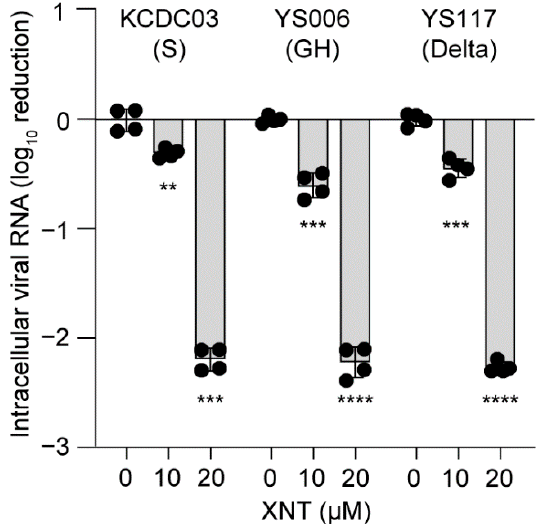
Figure 5. Inhibition of SCoV2 variants by XNT. Intracellular and extracellular viral RNA titers, de- termined 24 h after treatment of Vero E6 cells infected with SCoV2 KCDC03 (S clade), YS006 (GH clade), or a delta strain YS117 at an MOI of 0.01. Bar graphs show the mean with data points (two from each set) from two biological replicates. Vehicle, 0.1% DMSO. ** p < 0.01; *** p < 0.001; **** p < 0.0001; by unpaired two-tailed Student’s t -test.